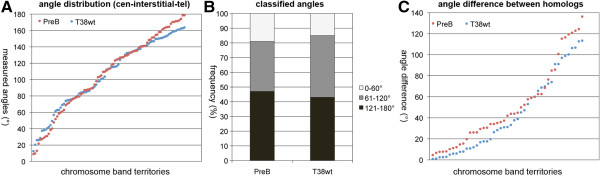
3D conformation analysis of chromosome 11 mBAND territories in Pre B lymphocyte nuclei and in B cell nuclei of congenic [T38HxBALB/c]N wild-type mice using measured angles between geometric centers of centromeric, interstitial (apex) and telomeric chromosome band territories in individual chromosomes A Distribution of measured angles in each 90 PreB and [T38HxBALB/c]N wild-type B individual chromosomes 11. B Bar diagram showing the percentage of angulated chromosomes with telomeric band territories in close proximity to centromeric regions (0-60° = chromosome 11 territory angulated), intermediate (61-120°) and straight chromosomes (121-180° = chromosome 11 territory straight) in the two cell lines. C Distribution of calculated angle differences between homologous CT pairs as a measure for the similarity of the 3D conformation of the two chromosomes 11 CT in individual nuclei.